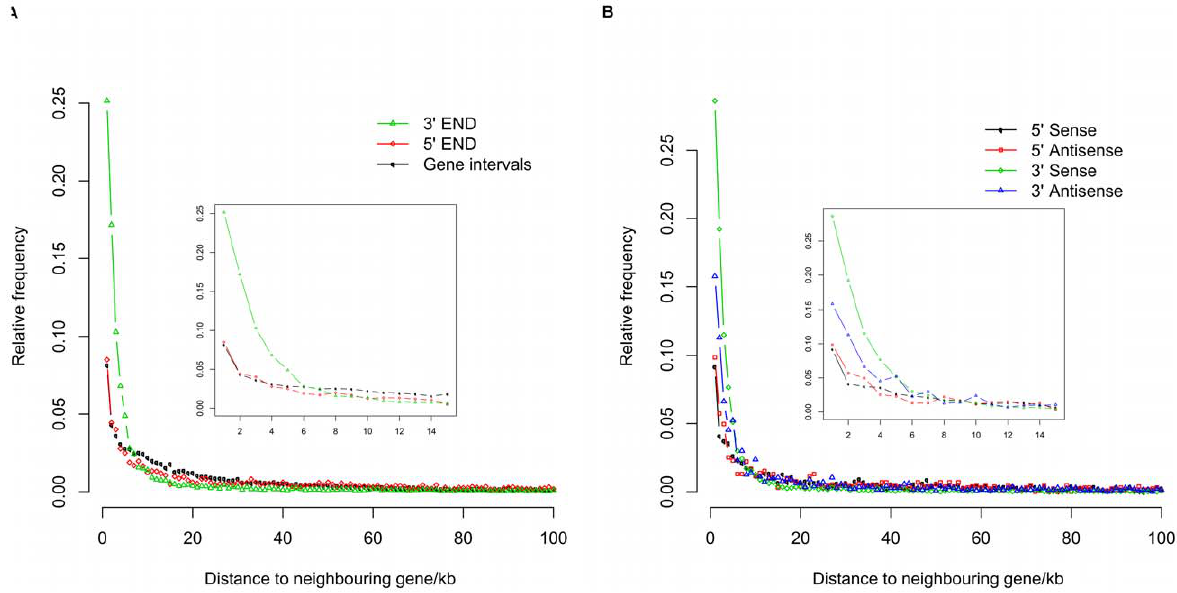
Figure 6. Positional bias distribution of ncRNAs with respect to neighbour genes. (A) Relative frequencies of ncRNAs with respect to the distance from neighbour genes. 100 kb adjacent to TSS or TTS of genes is shown in these plots. 3 9 END means the ncRNA is located in the 3 9 flanking region of its neighbour gene. 5 9 END means the ncRNA is located in the 5 9 flanking region of its neighbour gene. ‘‘Gene intervals’’ refers to the intergenic region of two adjacent genes. (B) Relative frequencies of ncRNAs from neighbour genes partitioned with respect to transcription orientation. The internal boxes represent the zoom in view of the relative frequencies from 5 kb to 20 kb.